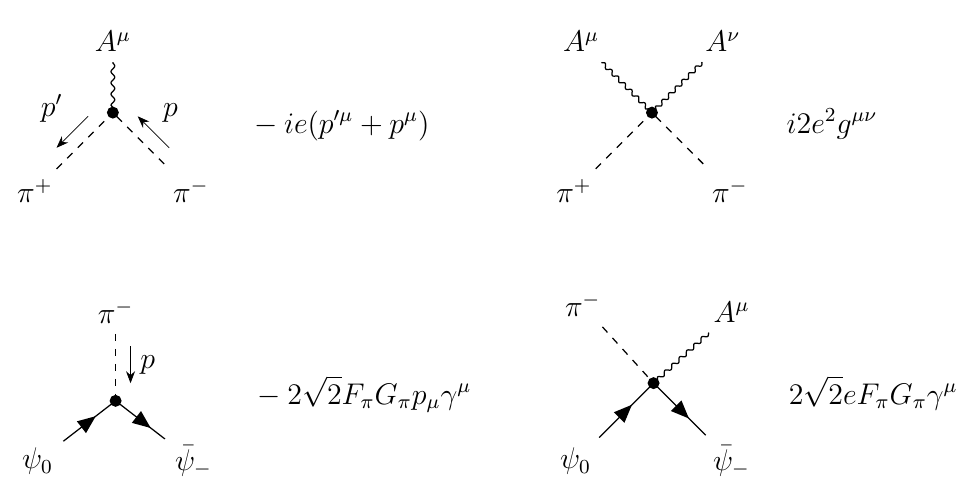
Figure 1 . The Feynman rules of the Wino-pion interactions. The arrow on the fermion propagator denotes the flow of the fermion number. We do not show the flow of the QED charge. In the figure, we show the names of the